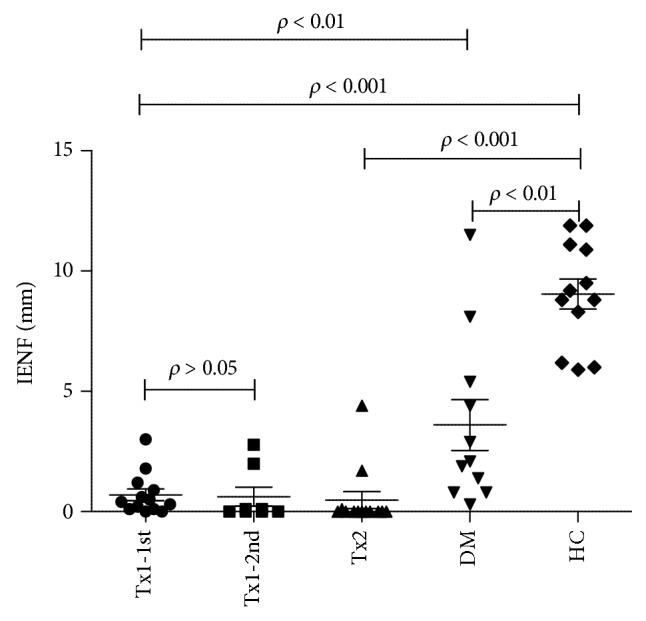
Scatterplot, IENF-density.